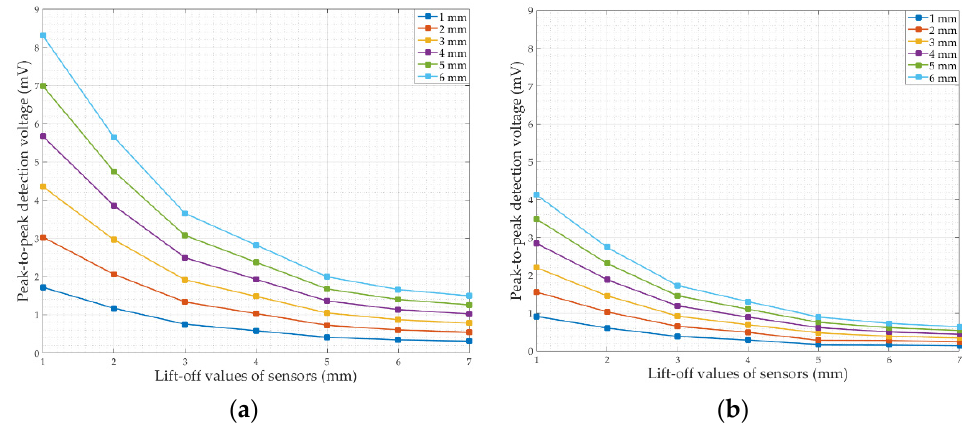
Figure 8. ( a ) Detection voltage amplitudes of circumferential cracks with different lift-off values of the sensor; ( b ) detection voltage amplitudes of axial cracks with different lift-off values of the sensor.